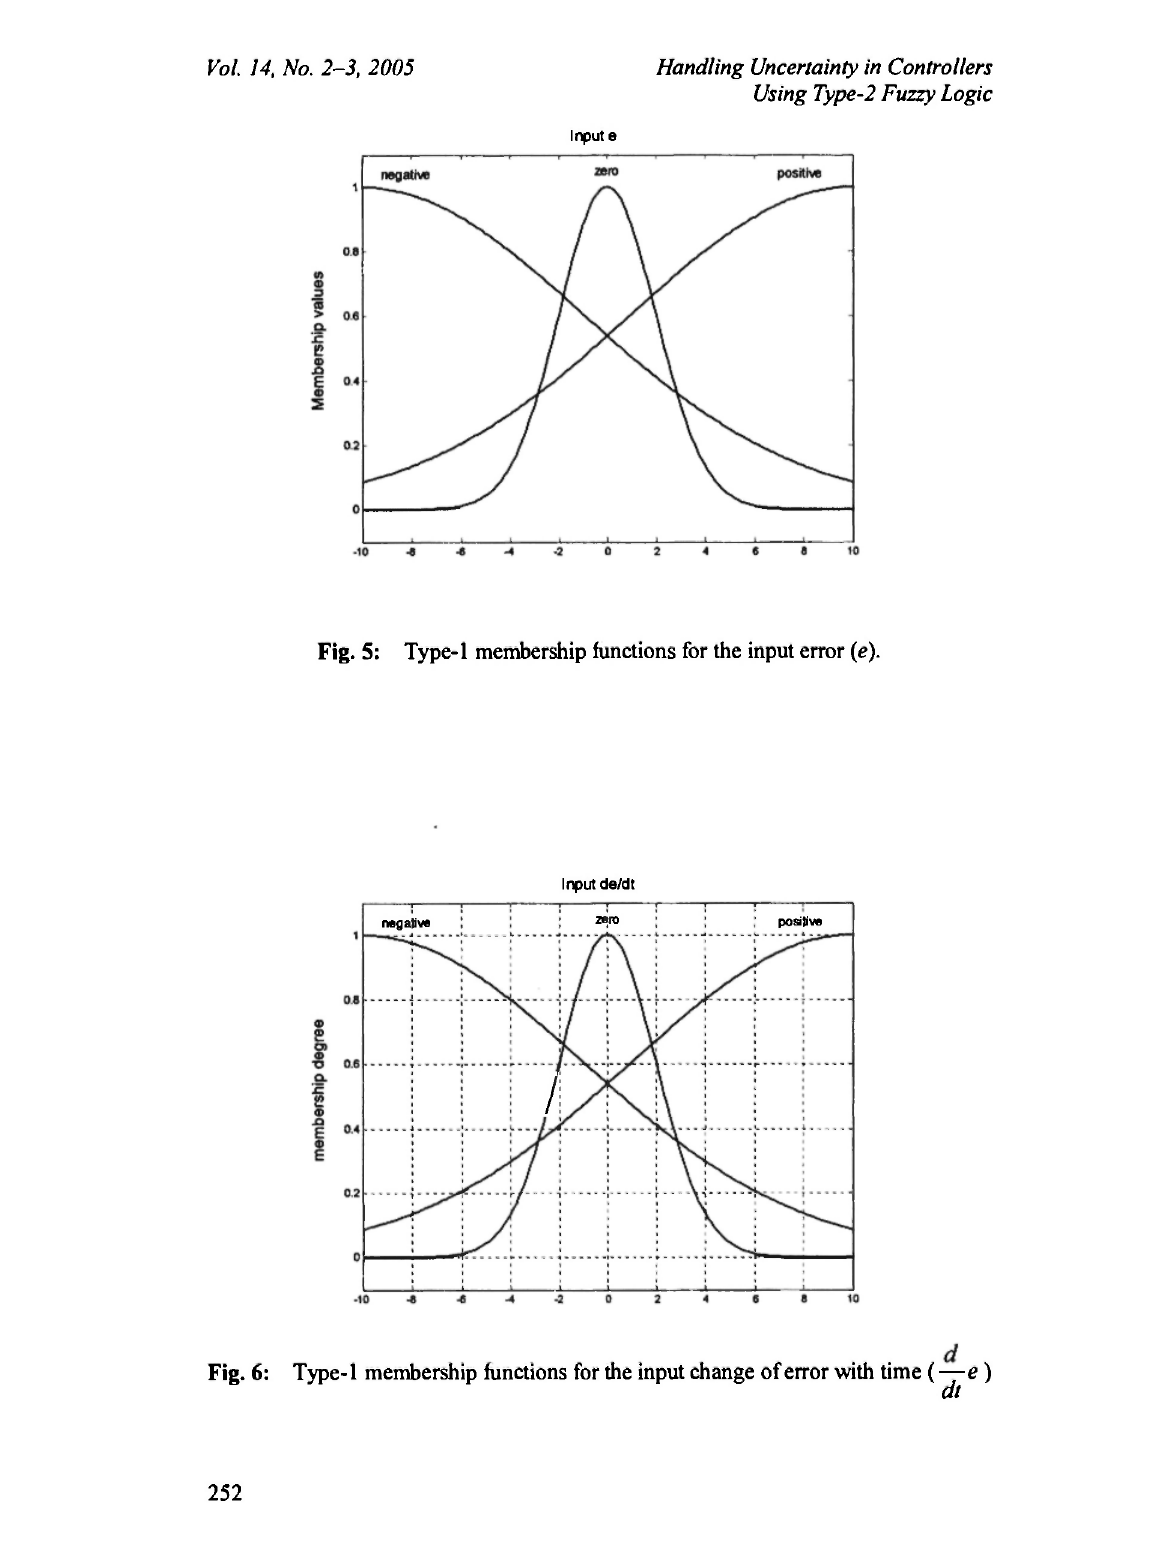
Fig. 6: Type-1 membership functions for the input change of error with time (—e )